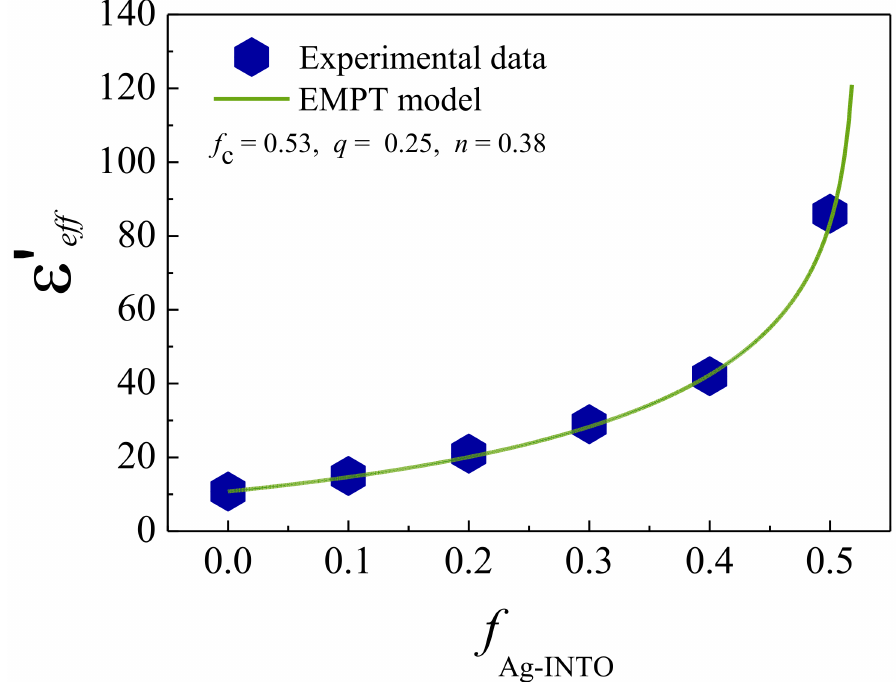
Figure 7. Experimental ε (cid:48) values for Ag − INTO/PVDF composites as a function of f Ag − INTO mea- sured at 1 kHz and 20 ◦ C fitted by EMPT